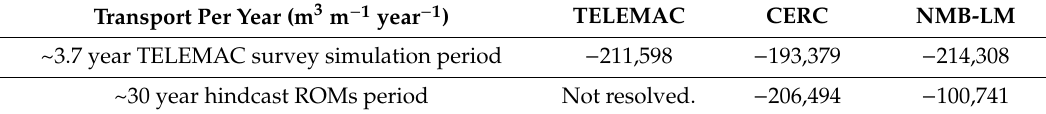
Figure 5. Time series of net longshore transport (m 3 ) from TELEMAC and empirical equations. On the vertical axis, positive (negative) values represent transport in the eastward (westward) direction. Table 1. Net modelled longshore sediment transport rate Q estimates averaged per